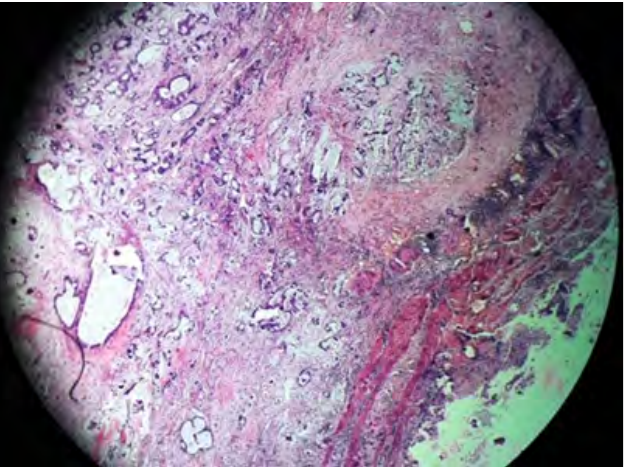
Fig 2 : H and E stained sections from adenocarcinoma, Not Otherwise specified, 4X. ( color picture available online